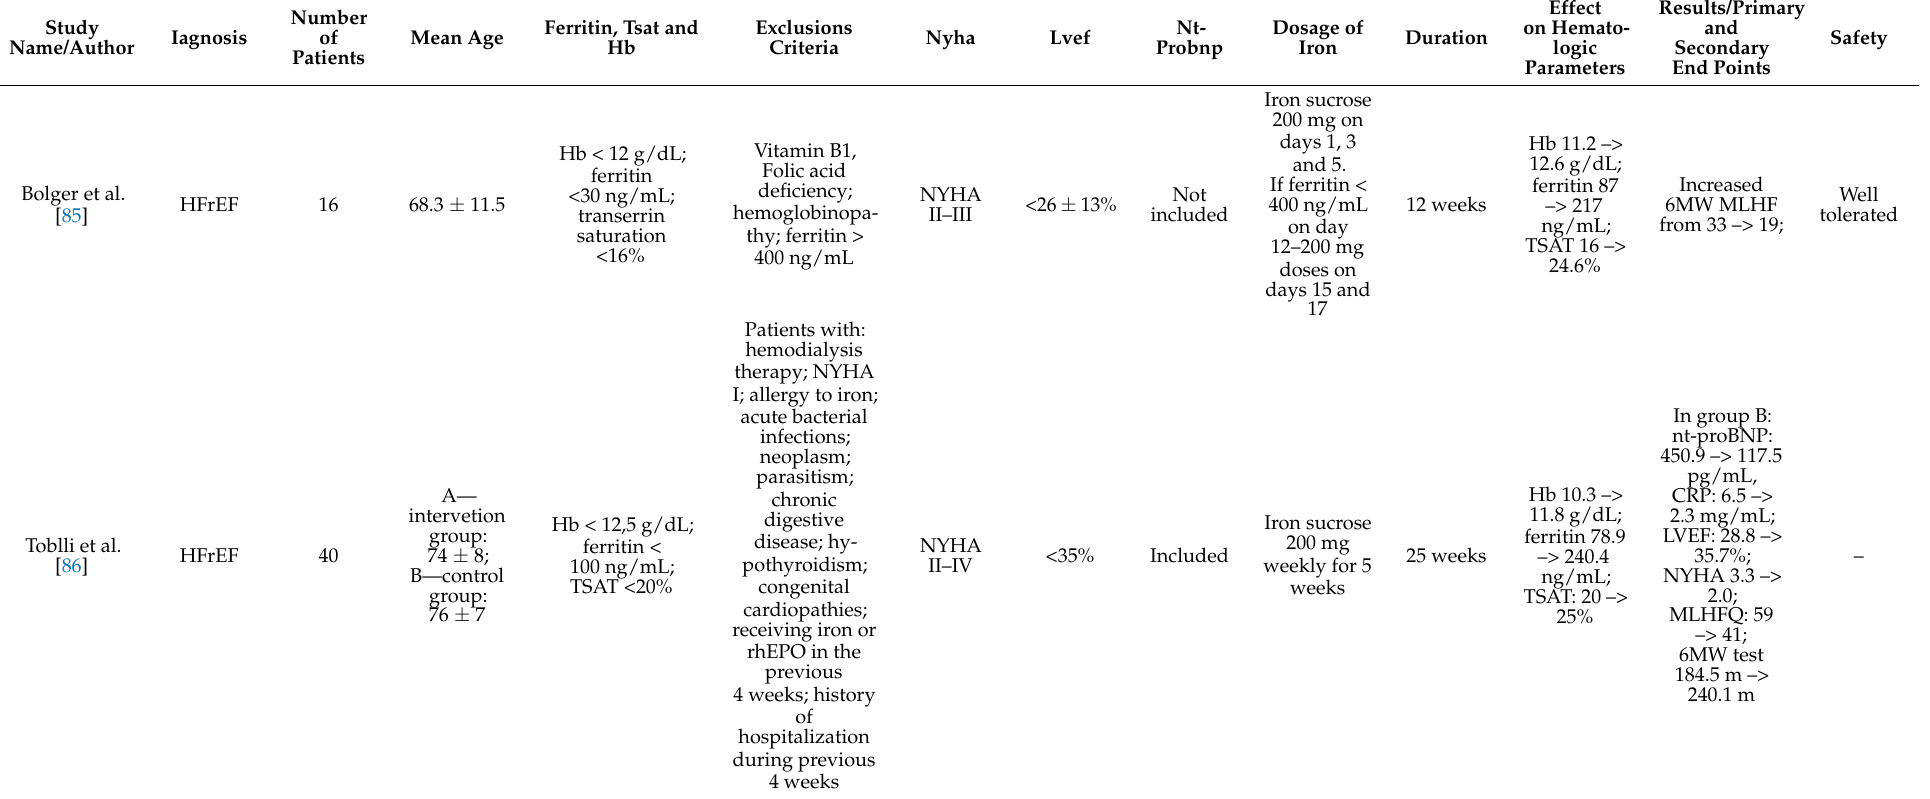
Table 1. A Interventional studies of iron deficiency in heart